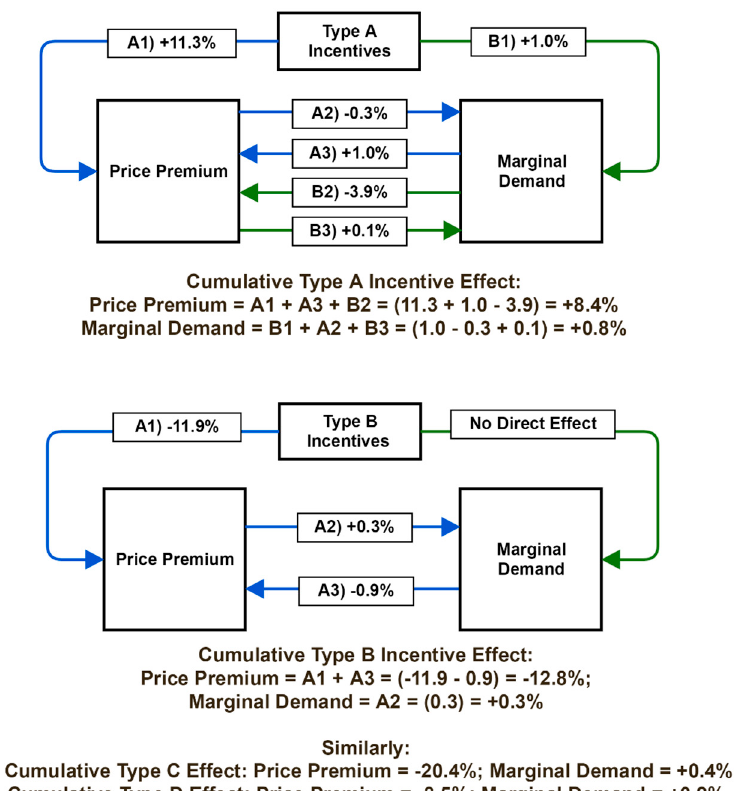
Figure 3. Indirect effects of different government incentives on Price Premium and Marginal Demand due to endogeneity for (a) Type A incentives and (b) Type B incentives.